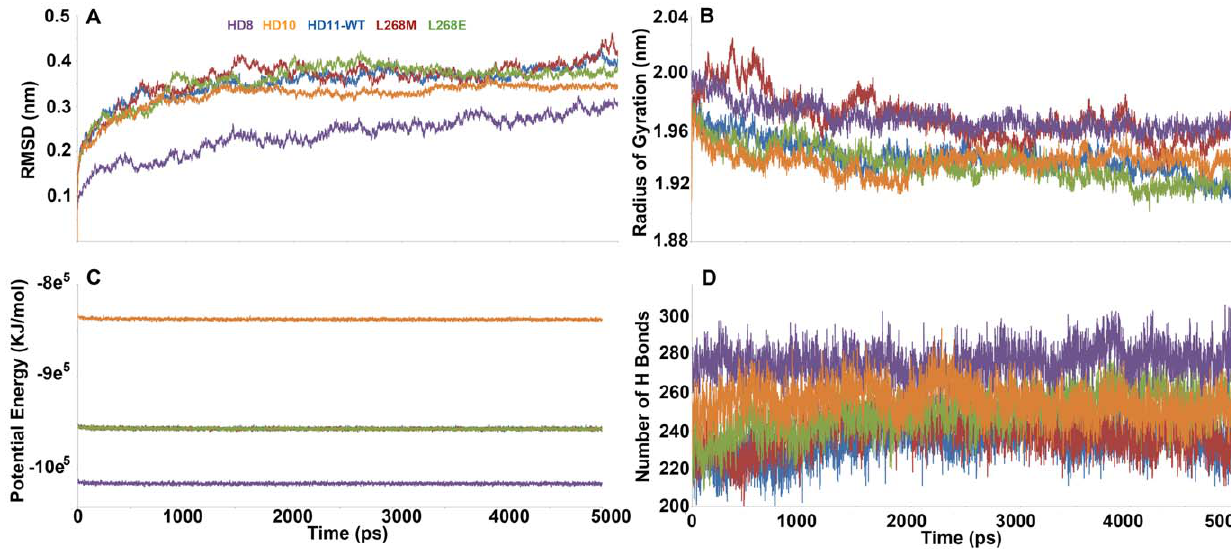
Figure 4. Basic MD analyses for all HDAC systems. (A) C a -RMSD, (B) radius of gyration, (C) potential energy, and (D) number of hydrogen bonds of all HDAC systems.